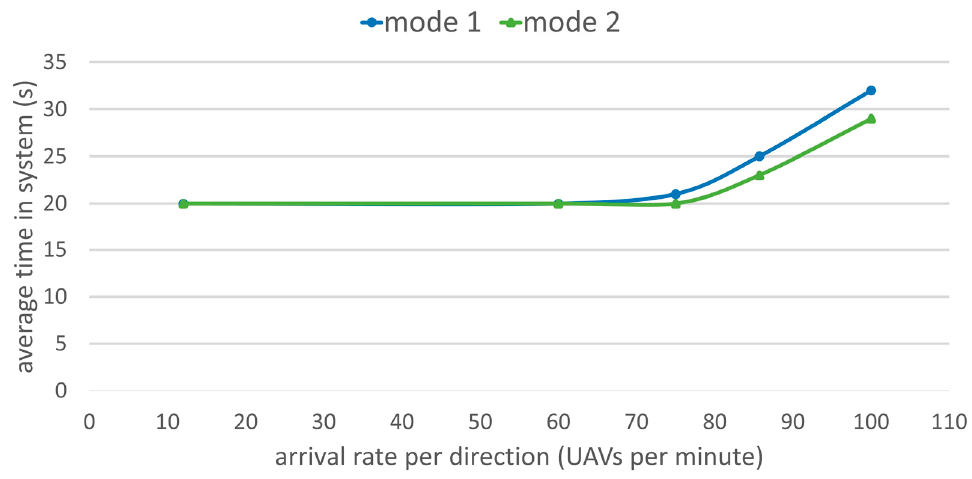
Figure 13. UAVs’ average time spent in the system in mode 1 and mode 2.